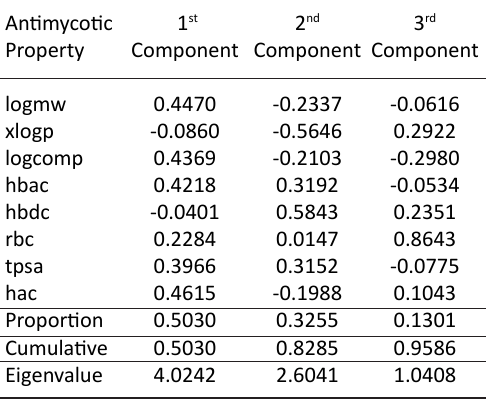
Table 2. Principal component loading values and eigenvectors.